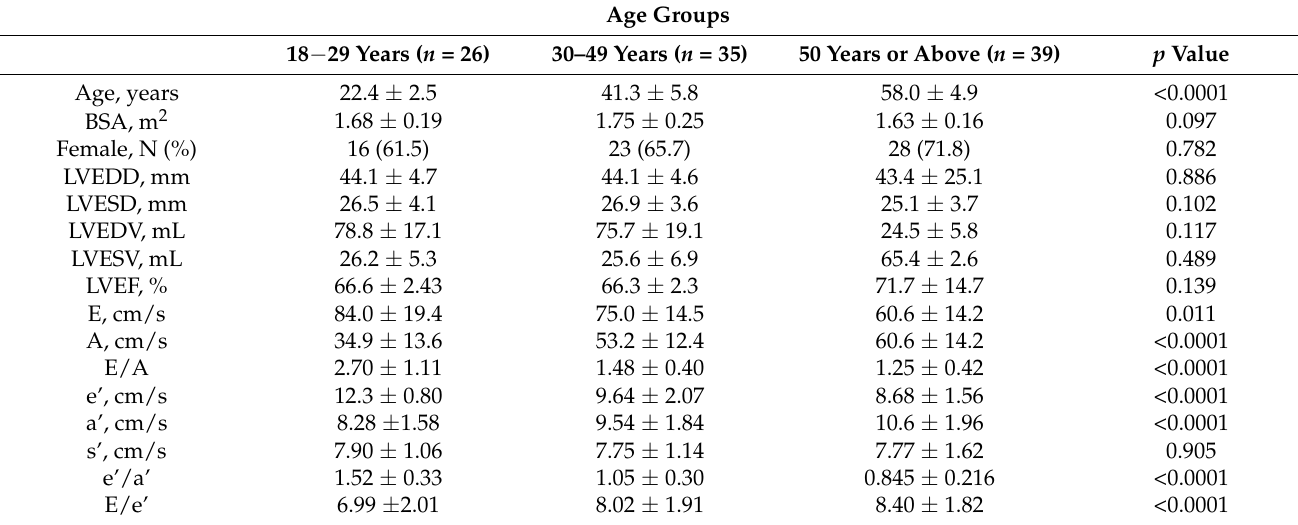
Table 1. Demographics and two-dimensional and Doppler echocardiographic parameters stratified by age groups. Age